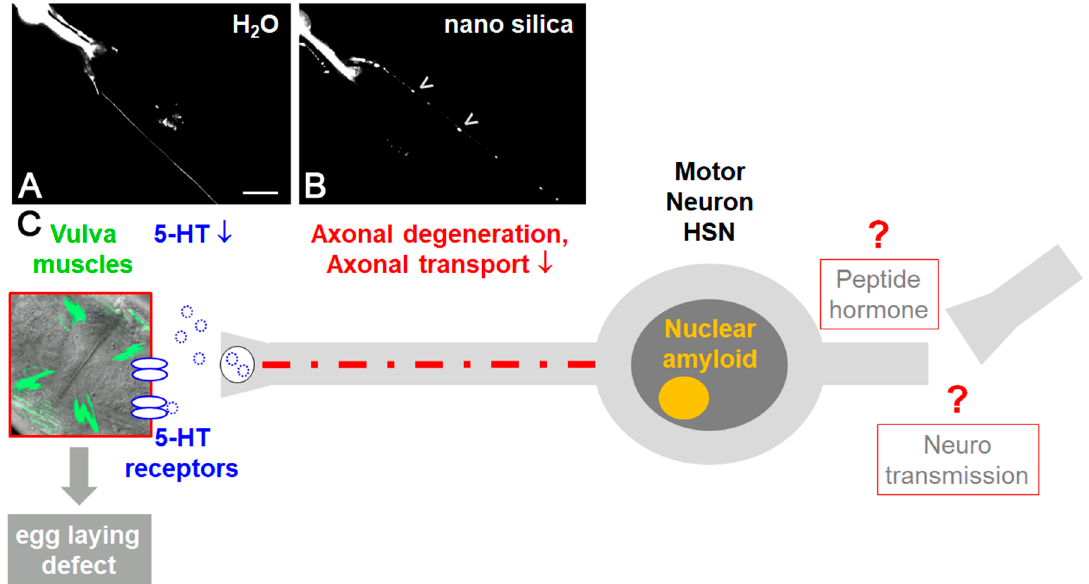
Figure 2. The neurotoxicity of nano silica in the neural system of the nematode Caenorhabditis elegans . Representative fluorescence micrographs of a single hermaphrodite-specific neuron (HSN): DsRed reporter worms of the neurotransmitter serotonin (5-hydroxytryptamine, 5-HT) were mock-treated with distilled water ( A ) or exposed to nano silica ( B ). Nano silica induced aggregation of DsRed-5-HT in the axon of the HSN neuron (( B ), arrowheads). ( C ) Schematic of nano silica e ff ects in C. elegans . Silica nanoparticles induce nuclear amyloid in single HSN neurons and protein aggregation on HSN axons. Axonal transport is disturbed and serotonergic neurotransmission at the synapse reduced. This in turn leads to defective vulva muscles and egg-laying defects [44]. Bar, 20 µ